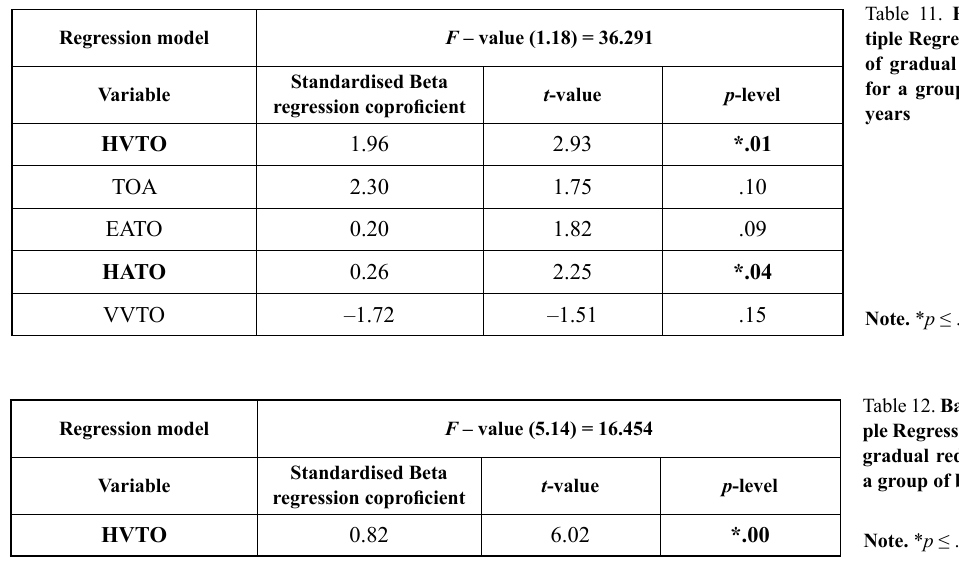
Table 13. Forward Stepwise Mul